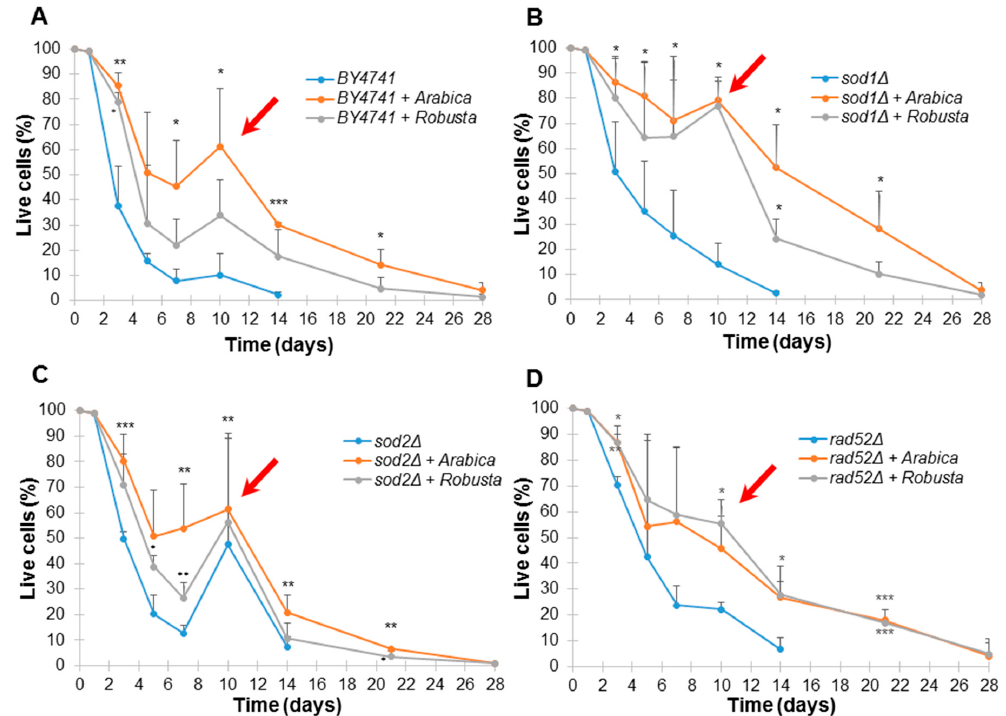
Figure 3. Chronological lifespan of the haploid wild-type yeast strain BY4741 ( A ) and isogenic mutant strains sod1 ∆ ( B ), sod2 ∆ ( C ) and rad52 ∆ ( D ) treated with Arabica and Robusta infusions co ff ee. Survival was determined by propidium iodide staining. Statistical significance was assessed using ANOVA and the Dunnett’s post hoc test (* p < 0.05; ** p < 0.01, *** p < 0.001) compared to the control (untreated). Bars indicate SD. Red arrows show adaptative